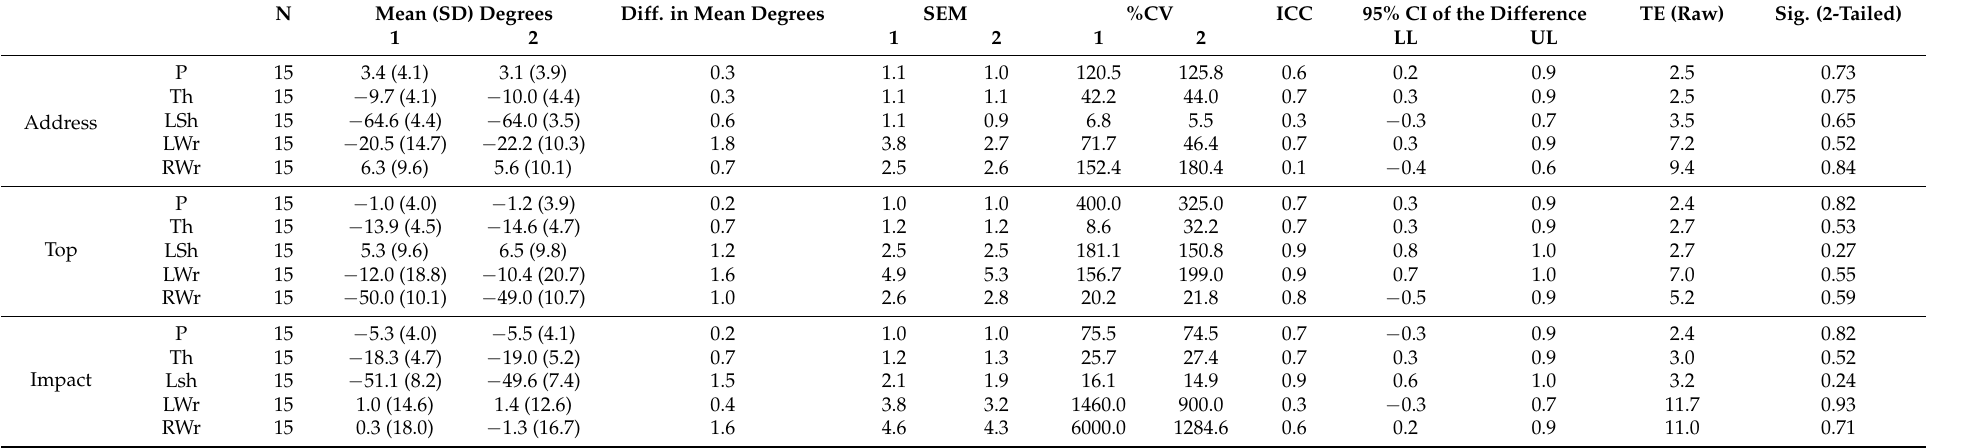
Table 2. Reliability of the Polhemus Liberty system for segment and joint angular kinematics in the medial/lateral